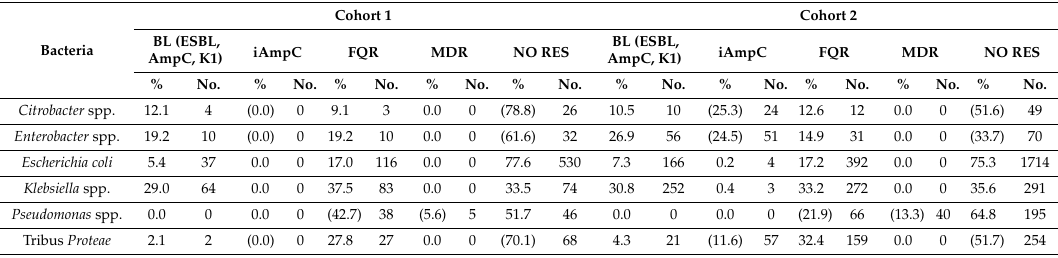
Table 1. Resistance levels of the most frequent pathogenic bacteria from urine samples before (Cohort 1) and after (Cohort 2) fosfomycin registration. Brackets indicate statistically significant di ff erences ( p < 0.05) between Cohort 1 and Cohort 2.